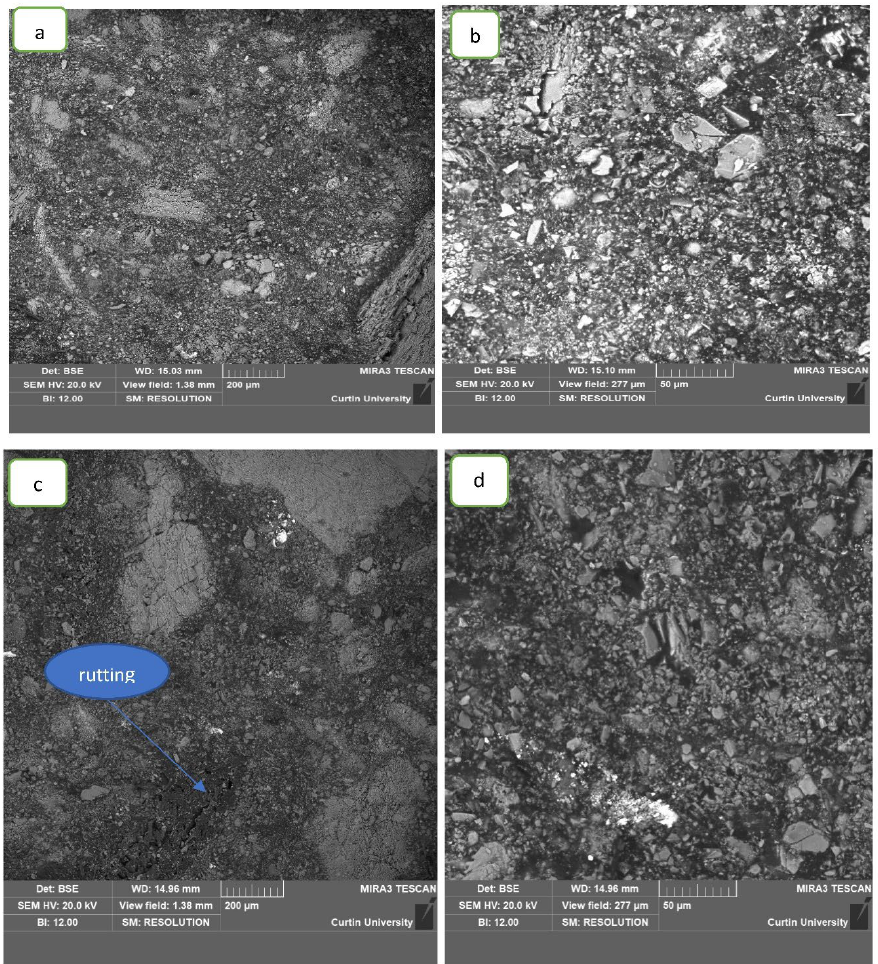
Figure 16. SEM structures of asphalt mixtures: ( a ) SMA modified with 8% PET at 200 µ magnification; ( b ) SMA modified with 8% PET at 50 µ magnification; ( c ) dense-graded asphalt modified with 8% PET at 200 µ magnification; and ( d ) dense-graded asphalt modified with 8% PET at 50 µ magnification.